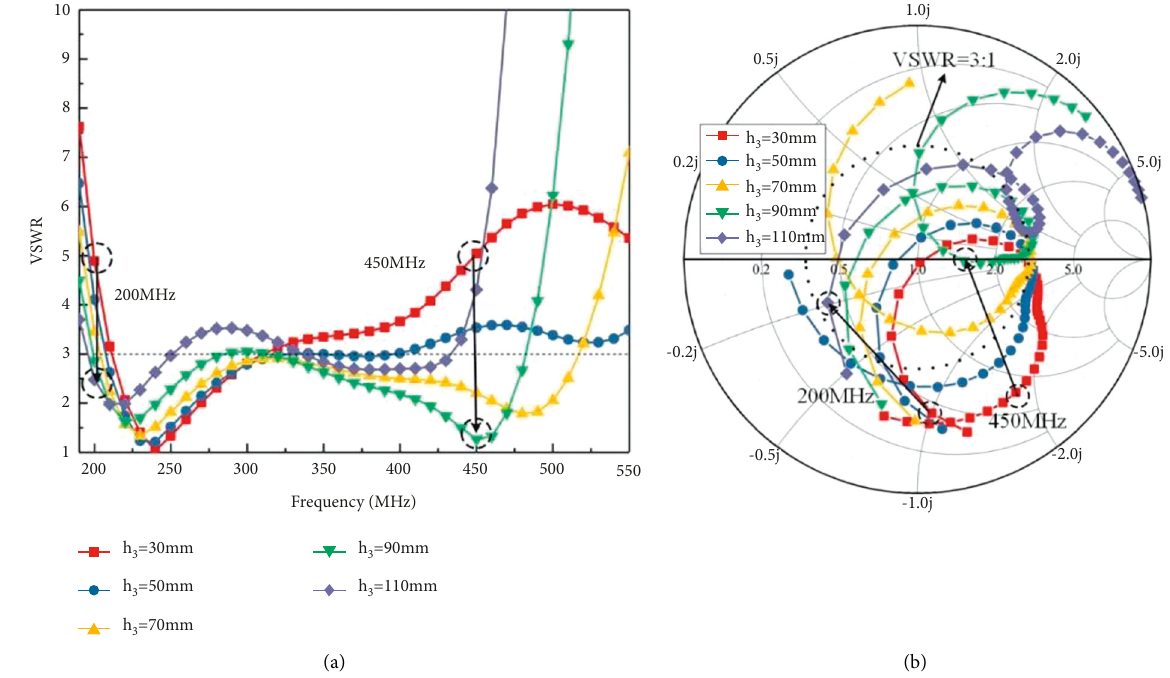
Figure 9: (a) VSWR curves and (b) Smith charts with different values of h